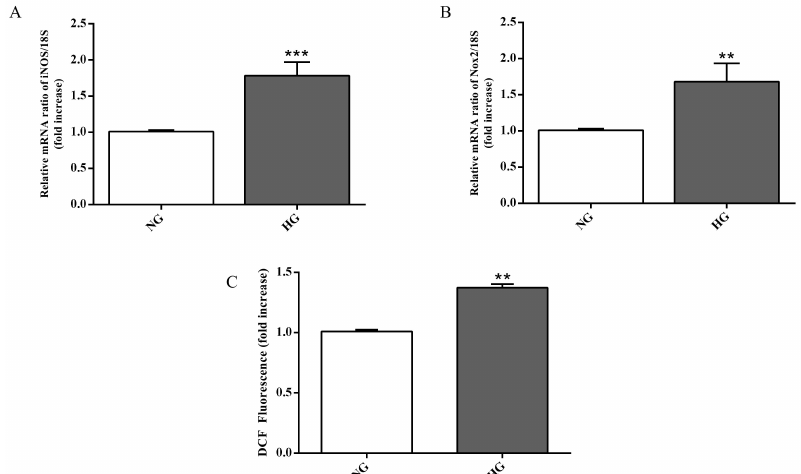
Figure 5. Measurement of ( A ) iNOS and ( B ) Nox2 expression levels (qRT-PCR) in astrocytes subjected to normal or high glucose conditions for 48 h. The abundance of each mRNA of interest was expressed relative to the abundance of 18S rRNA, as an internal control. ( C ) Intracellular ROS production in astrocytes under normal and high glucose conditions. NG = normal glucose condition (5 mM); HG = high glucose condition (40 mM). Values are means ± SD of three to four independent experiments. Statistical analysis was performed using Student’s t-test. ** p < 0.01 vs. NG; *** p < 0.001 vs.